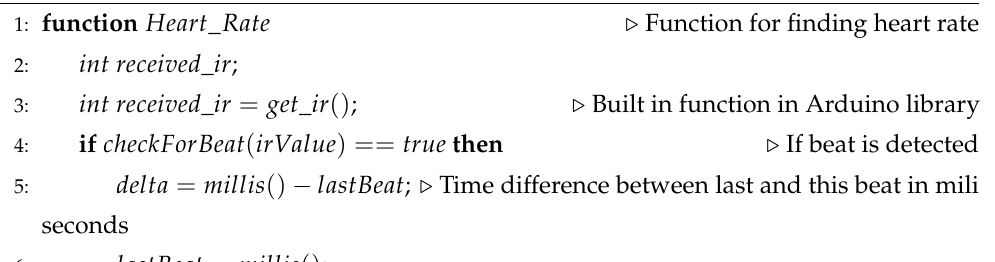
Algorithm 2 Extracting SpO 2 and Heart